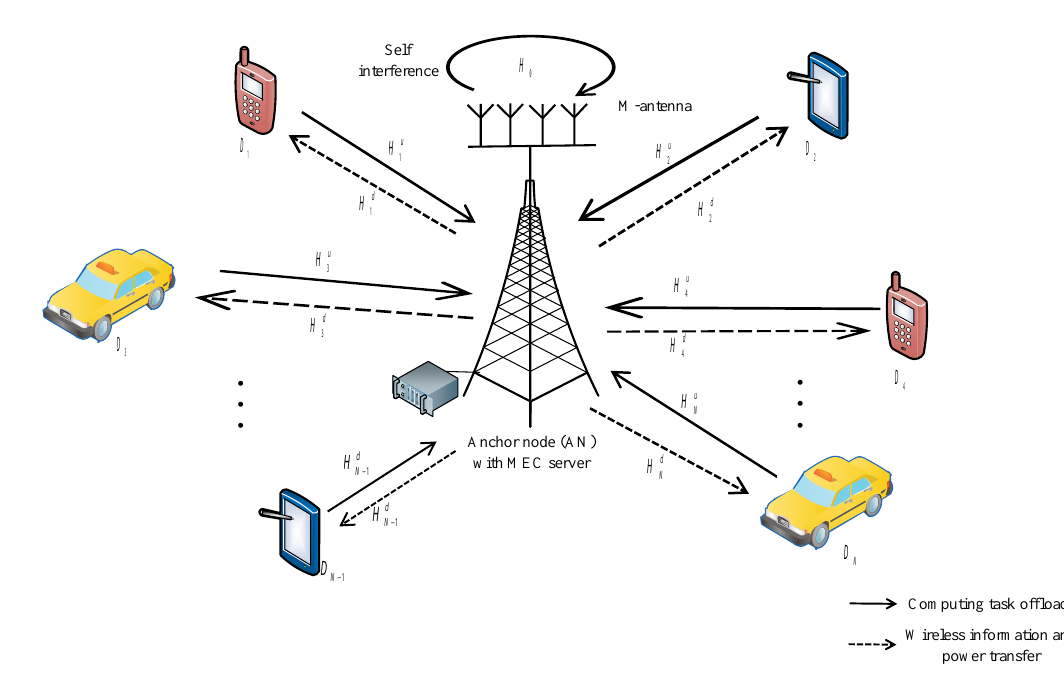
Figure 1. SWIPT-MEC enabled WSN assisted IoT System